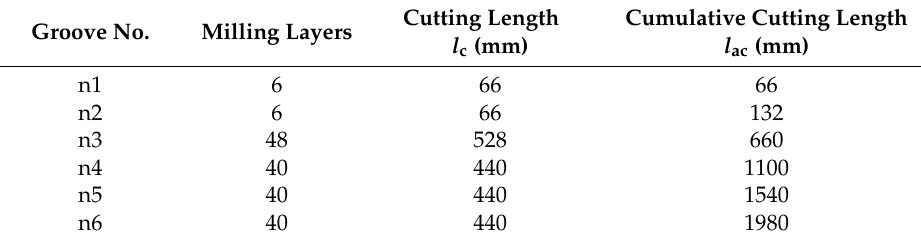
Table 4. Grooves machined at different cutting length for each test sample.